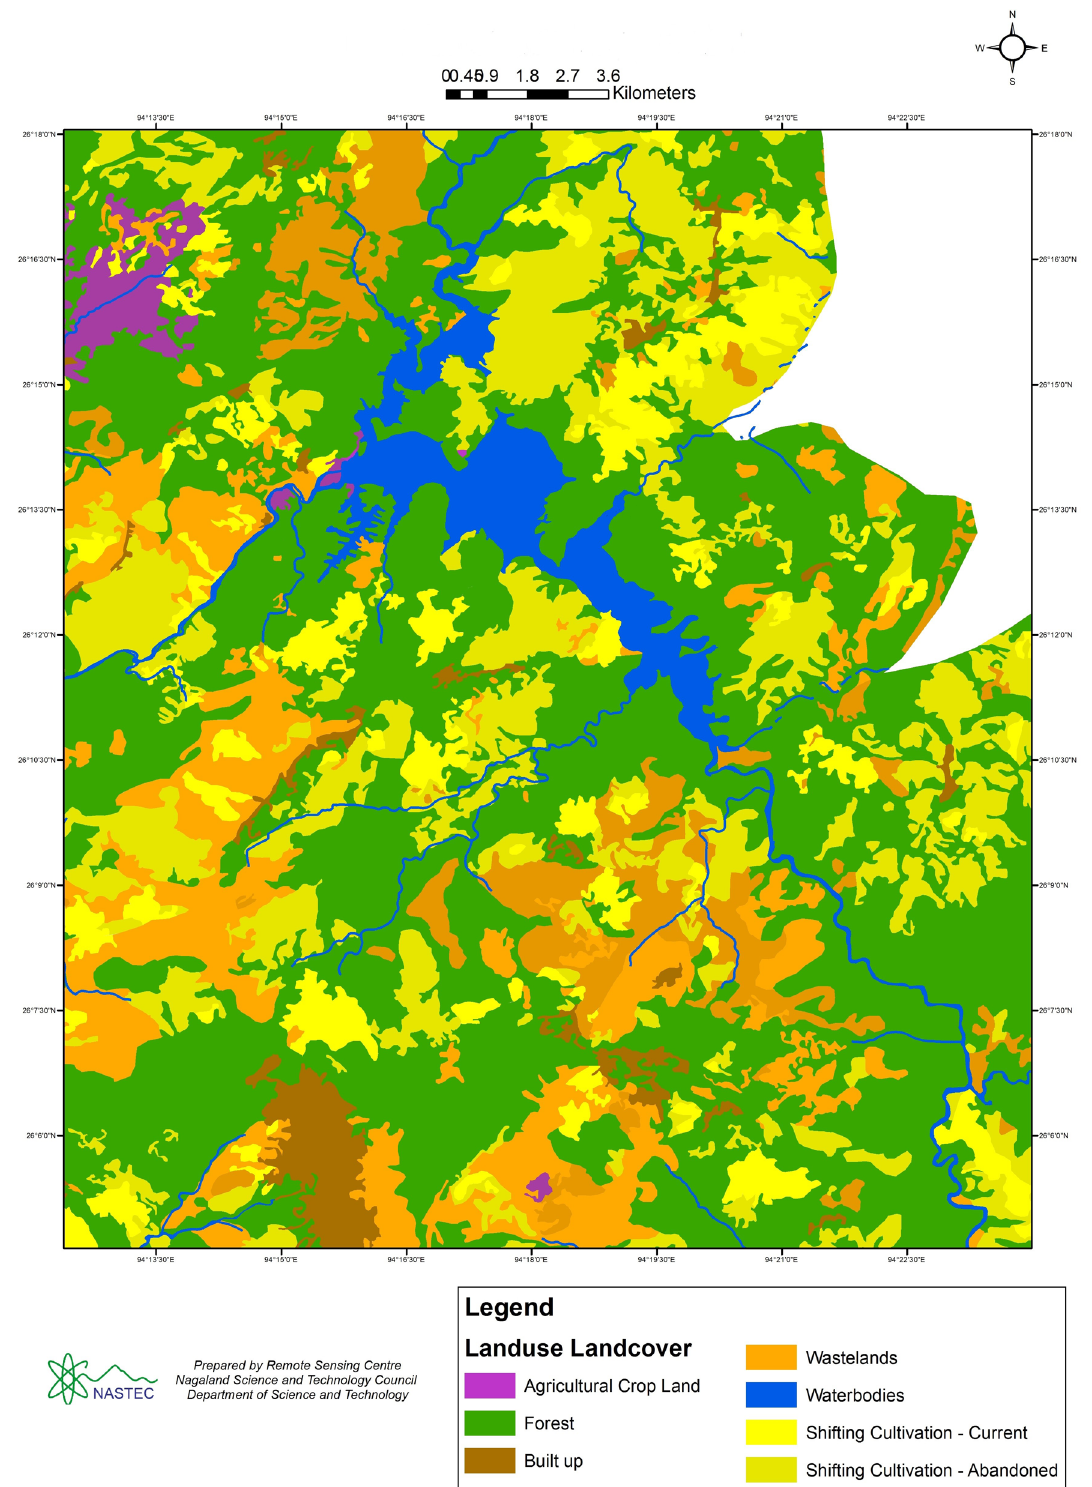
Fig. 1 Map showing the landuse/landcover (LULC) of the study